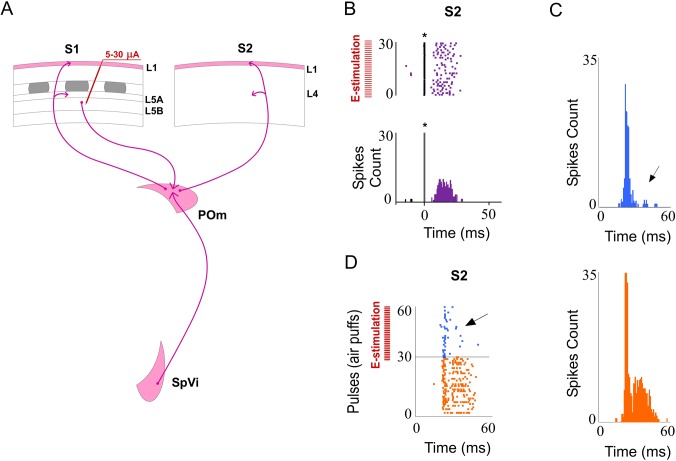
L5 E-stimulation in S1 before sensory stimulus modulates S2 whisker responses.(A) Schematic diagram summarizing the corticothalamocortical circuitry from S1 to S2 through the POm. The experimental manipulation of the barrel cortex is also shown. (B) An example of S2 evoked orthodromic spikes by L5 E-stimulation in barrel cortex is shown. * indicates stimulation artifacts. (C, D) L5 E-stimulation in barrel cortex just before whisker stimulus reduced responses in S2. Raster plots (D) and PSTHs (C) are shown for a sample infragranular response. L5 E-stimulation in S1 shortened responses and reduced spikes mainly in the second response component (arrows). Control (orange) and POm E-stimulation (blue) conditions are shown. Spikes are aligned on sensory stimulus (air puff) presentation (Time 0 ms). L5 E-stimulation in S1 was applied 150 ms before air puffs (31 to 60 pulses; red bars).